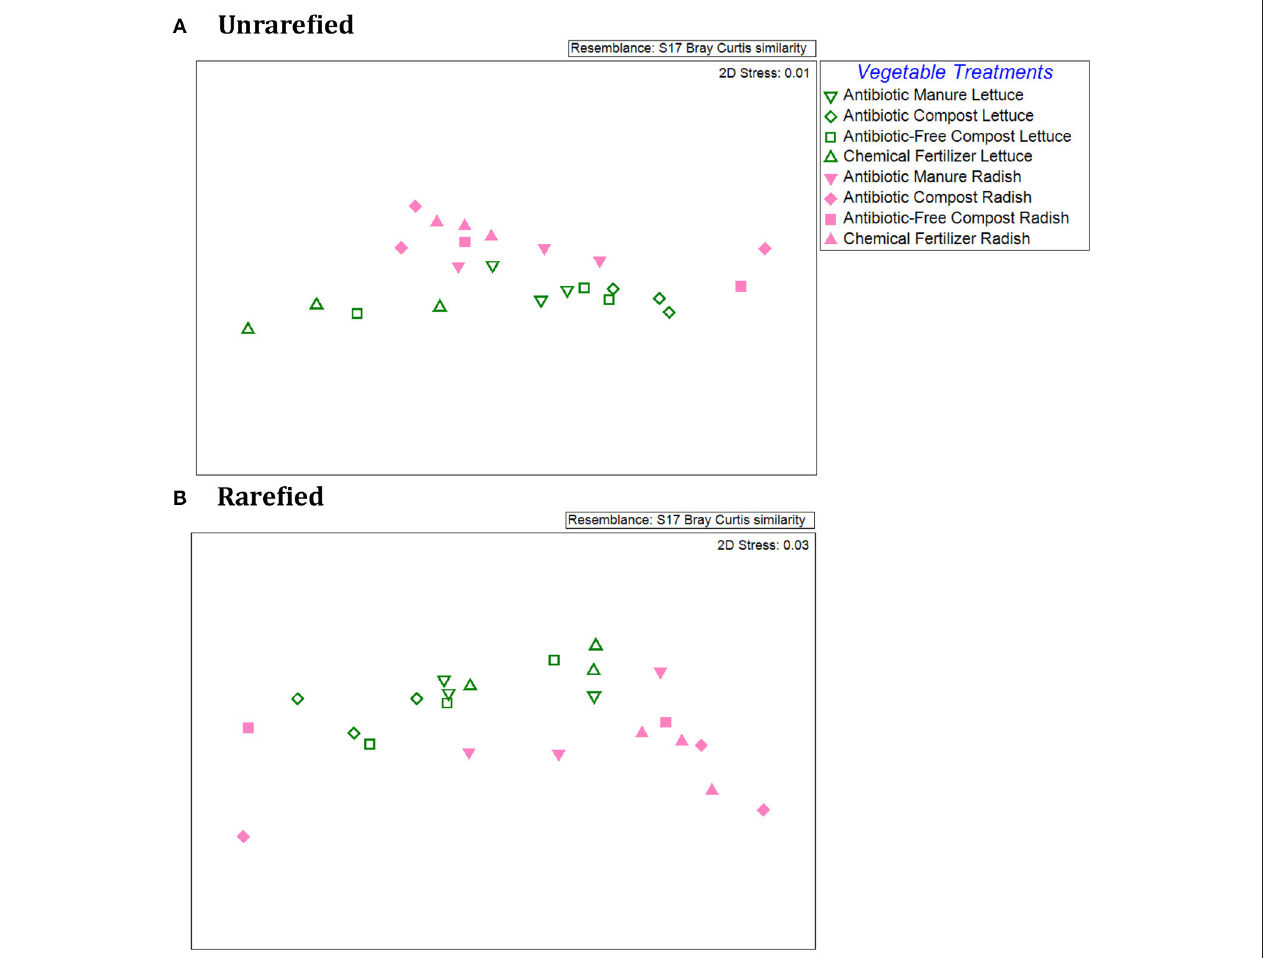
FIGURE 4 | Comparison of lettuce and radish resistomes across amendment conditions via non-metric multidimensional scaling (NMDS) analysis of Bray Curtis similarities of the relative abundances of ARGs detected via shotgun metagenomic sequencing and comparison to CARD 1.2.1. (A) Unrarefied data without chloroplast 16S rRNA gene sequences removed, where vegetable types were weakly separated ( R = 0.218; p = 0.087) and amendment conditions across both vegetable types were separated ( R = 0.266; p = 0.022) (2-Way ANOSIM). Pairwise comparisons indicated separation between chemical fertilizer and antibiotic manure ( R = 0.556, p = 0.02), chemical fertilizer and antibiotic compost ( R = 0.418, p = 0.03), and antibiotic compost and antibiotic manure ( R = 0.463, p = 0.03). (B) Rarefied data with chloroplast 16S rRNA removal. Rarefied resistomes were separable based on vegetable type ( R = 0.30, p = 0.036), but lettuce or radish resistomes were not separable based on different amendment types ( R = 0.1, p =